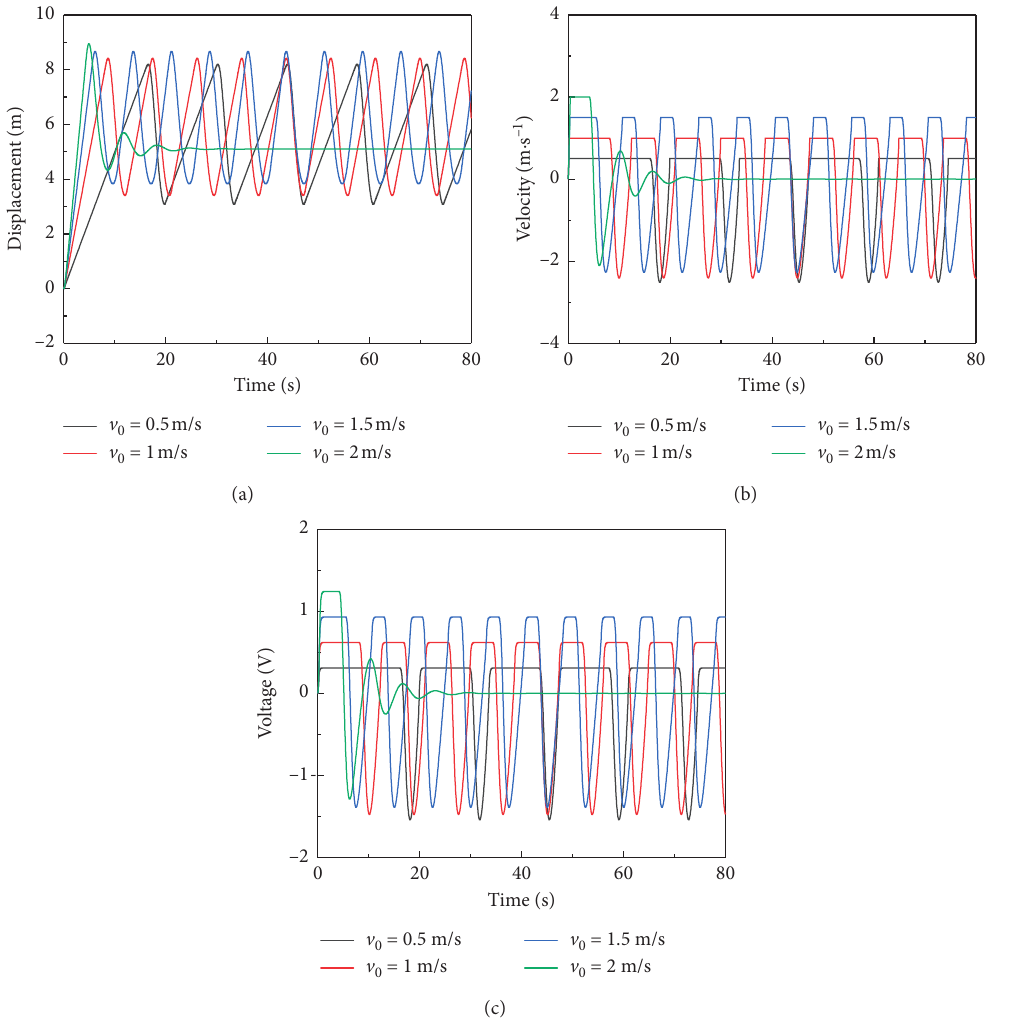
Figure 7: The displacement (a), velocity (b), and output voltage (c) of the friction system with different velocities in the friction law II.